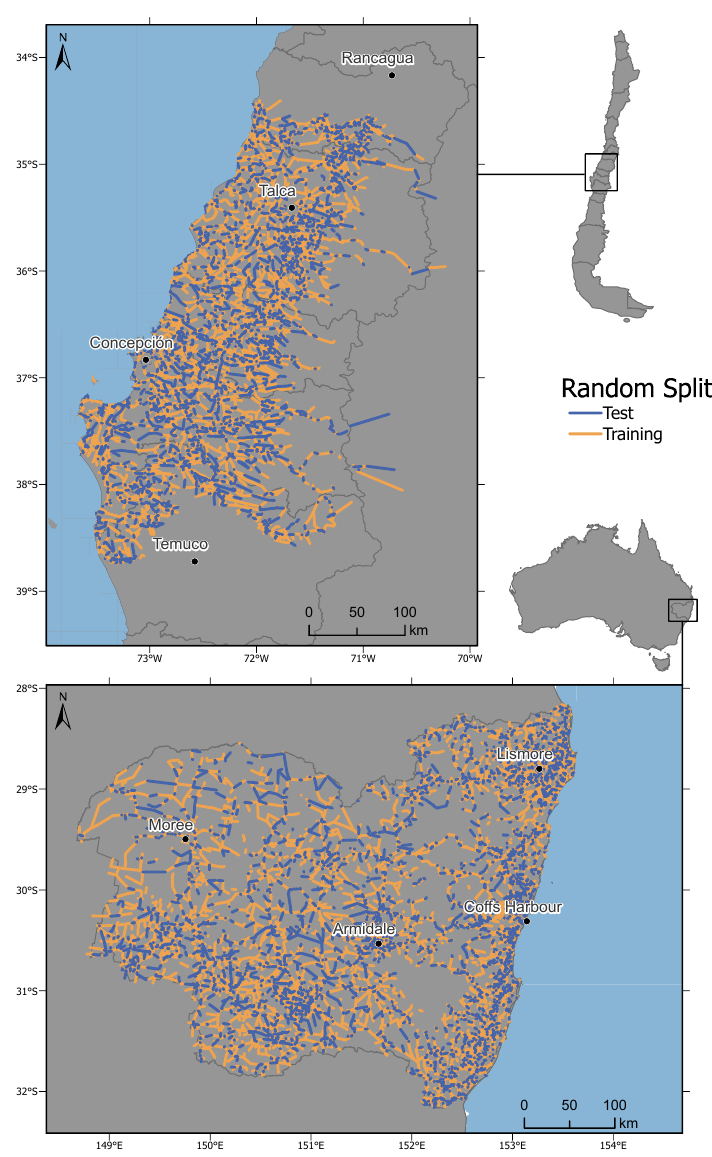
Figure 4. Visualization of the dataset splitting for BM dataset (on the top) and NNSW dataset (on the bottom) as spatial